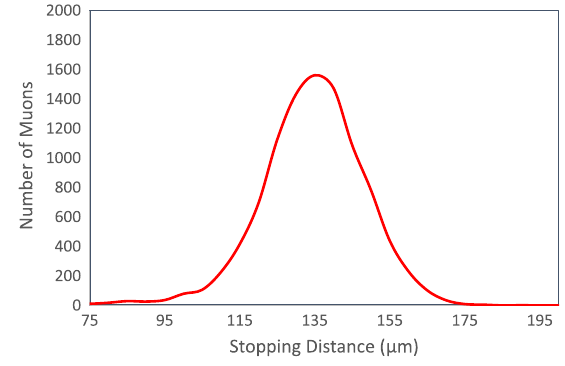
FIG. 3. Muon stopping distance in Nb as simulated by TRIM. The simulation takes into account all obstacles the muons encounter in their path such as beamlinewindows and